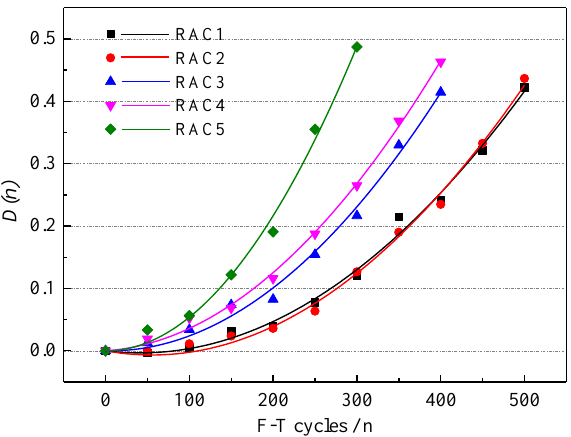
Figure 10. The variations of MLR ( a ) and RDME ( b ) of RAC- i.